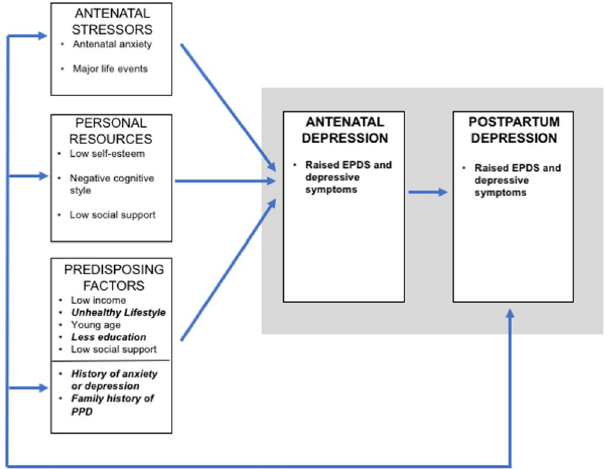
Figure 4. A modified version of the Leigh and Milgrom 8 biopsychosocial model of perinatal depression, incorporating findings from our